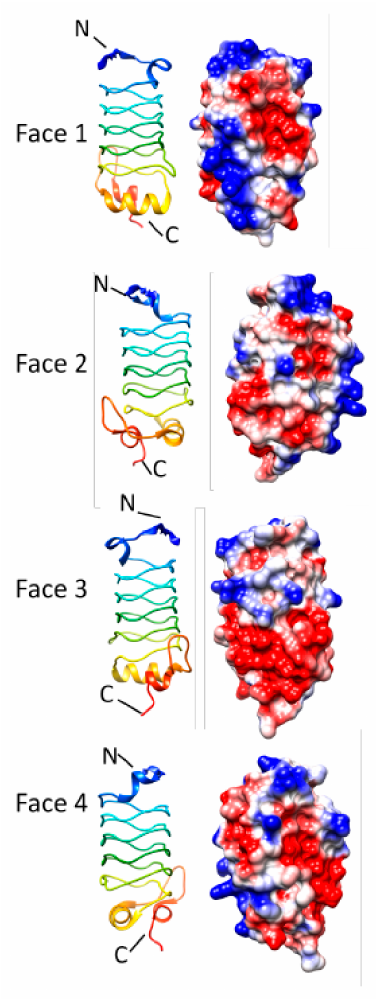
Figure 19. Structure and analysis of At2g49920.2. Ribbon diagrams of the structure (PDB ID: 3N90) for four different orientations (at left) and the corresponding electronic potential surface plots (at